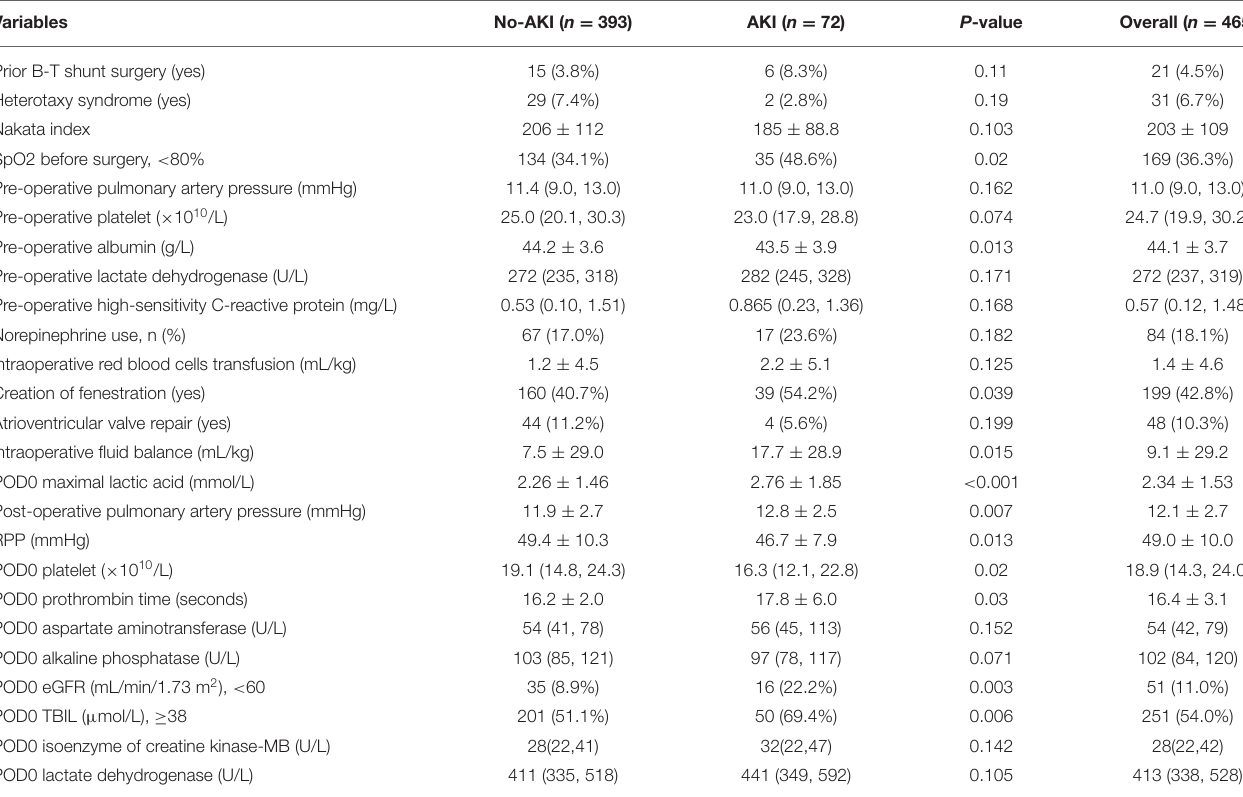
TABLE 1 | The perioperative characteristics of the study patients with p < 0.2 between yes and no persistent AKI.